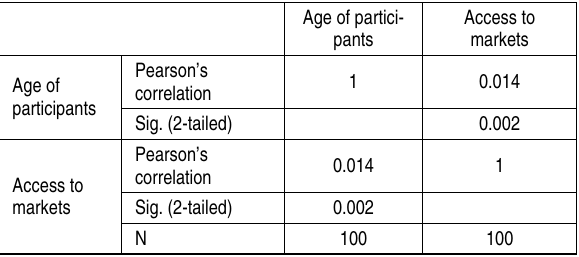
Table 3. Age versus access to markets